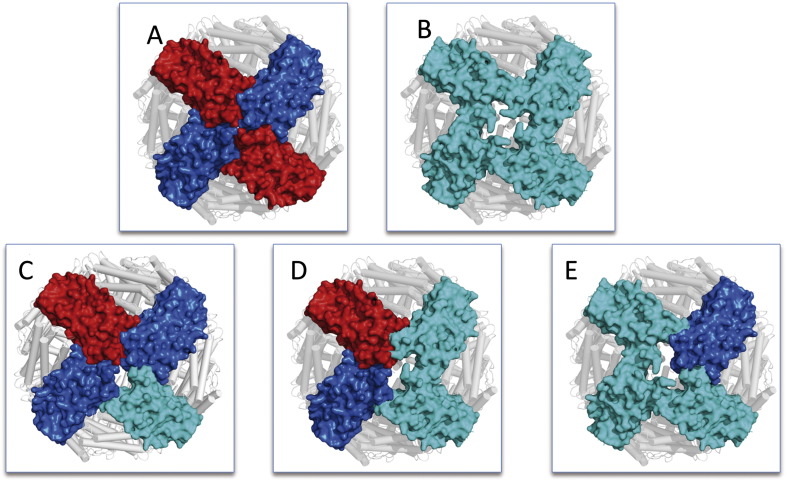
Molecular surface representation of ferritin subunits forming the 4-fold axis hydrophobic pore. A Representative wild type pore formed by two FtL (blue) and two FtH (red) chains. The wild type channel appears very narrow due to the presence of tightly packed hydrophobic residues. B Putative pore formed by 4 identical FtLPhe167SerfsX26 subunits (cyan). The opening of the pore is largely increased, altering the iron permeability of the ferritin shell. In patients carrying FtL mutation, two different L chain alleles (wild type and mutated), in addition to the wild type H chain, are expressed; therefore, mixed heteropolymers are likely to occur. Three putative combinations of FtL (blue), FtH (red) and FtLPhe167SerfsX26 (cyan) subunits, have been reconstructed in panels C, D, and E, increasing the proportion of mutated chain. The pore width increases proportionally to the number of variant chains participating in the tetramer assembly. (The structure of FtLPhe167SerfsX26 variant was obtained from Protein Data Bank. PDB code: 2KXU).